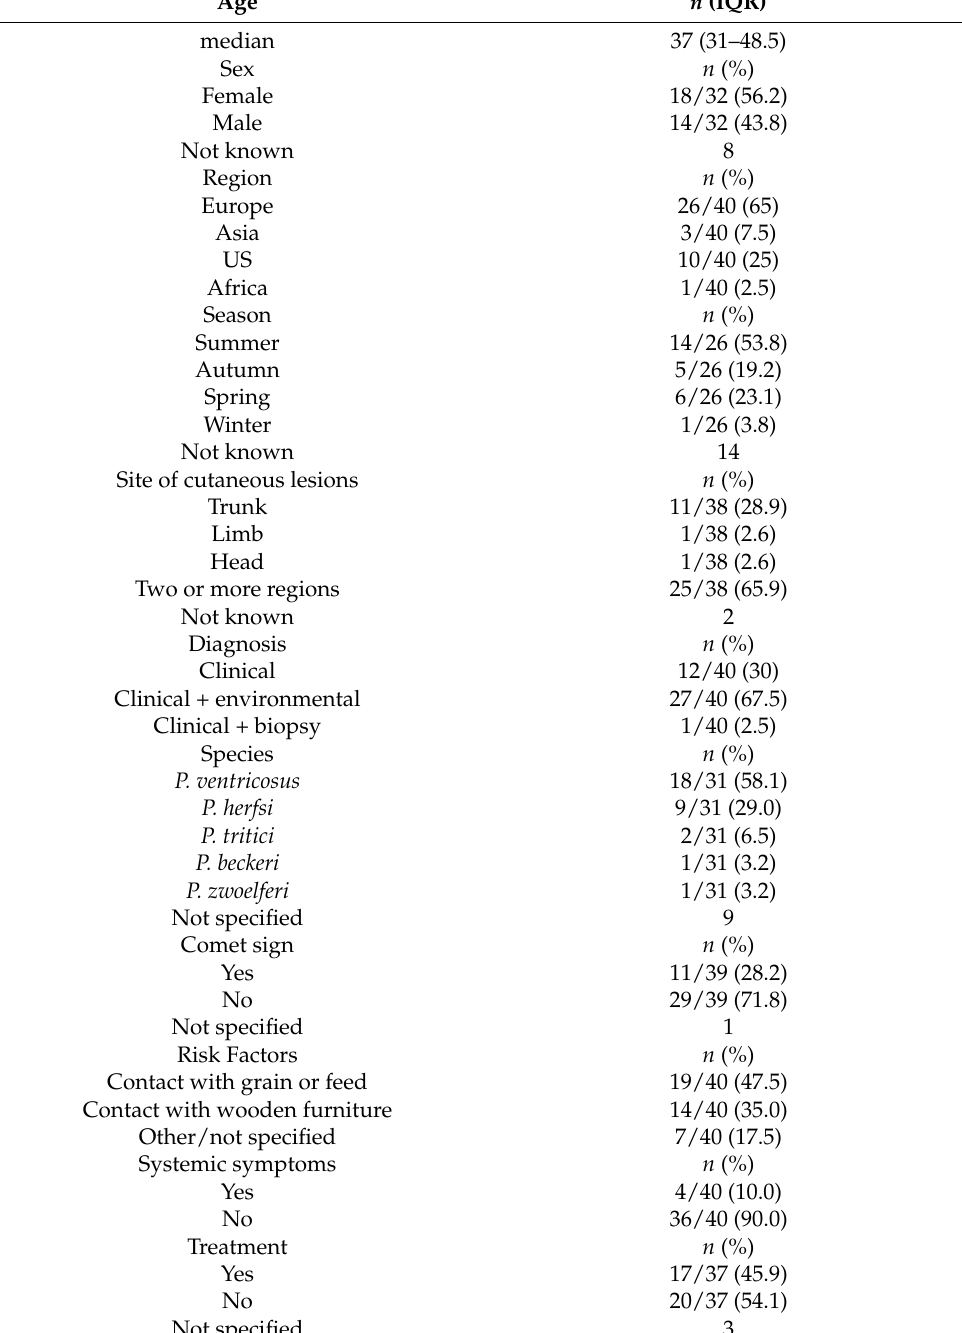
Table 1. Table 1. Epidemiological and clinical characteristics of case